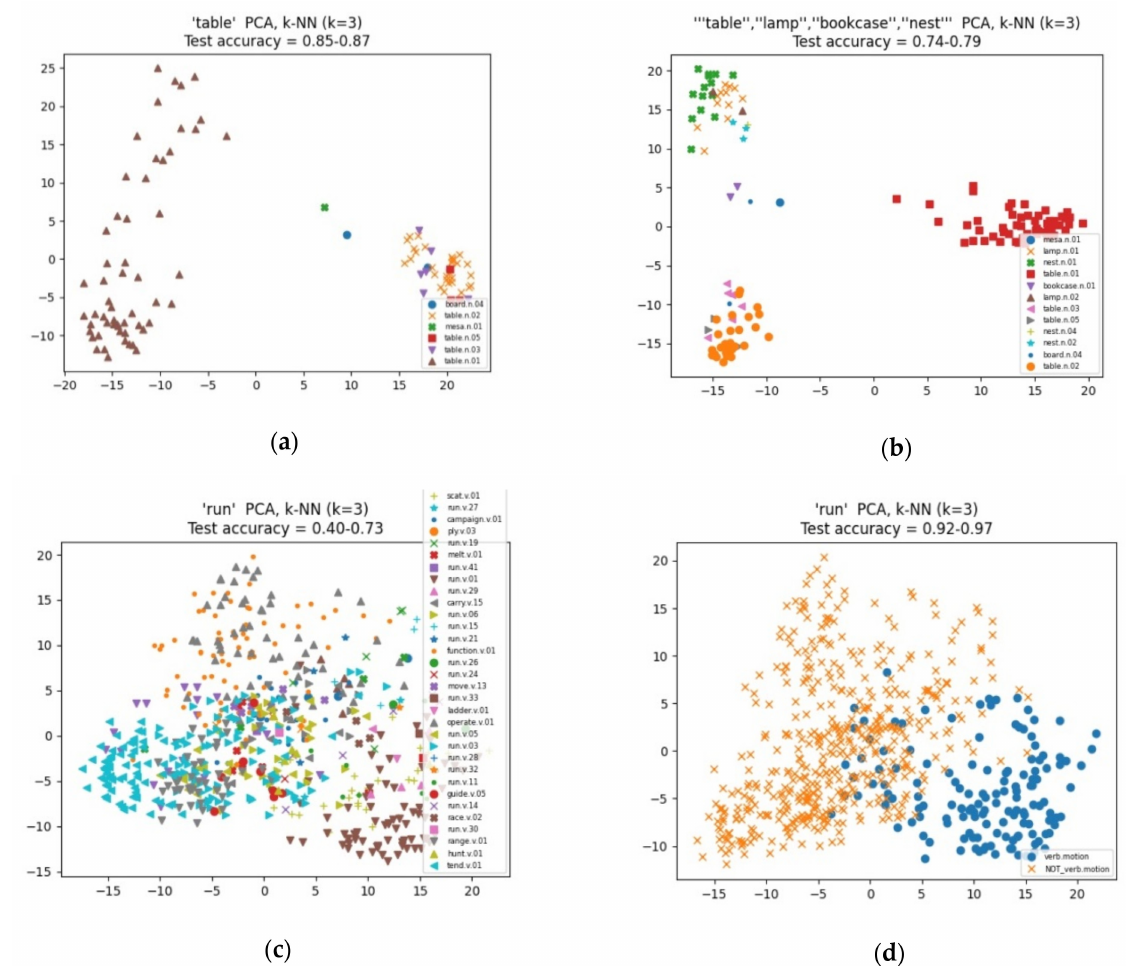
Figure 7. Clustering of word embeddings in the WordNet corpus, ( a ) all embedded examples for the word “table”, ( b ) examples for the words: “table”, “lamp”, “bookcase”, “nest”, ( c ) embedded examples for the word “run”, ( d ) senses for the word “run” after labeling them into two groups: “Motion” and “NoMotion”. Each subplot has two accuracy values: the first value represents the classification accuracy when the data points are projected on the two principal components, and the second value represents the k-NN classification when the data points are original vectors in 1024-dimensional